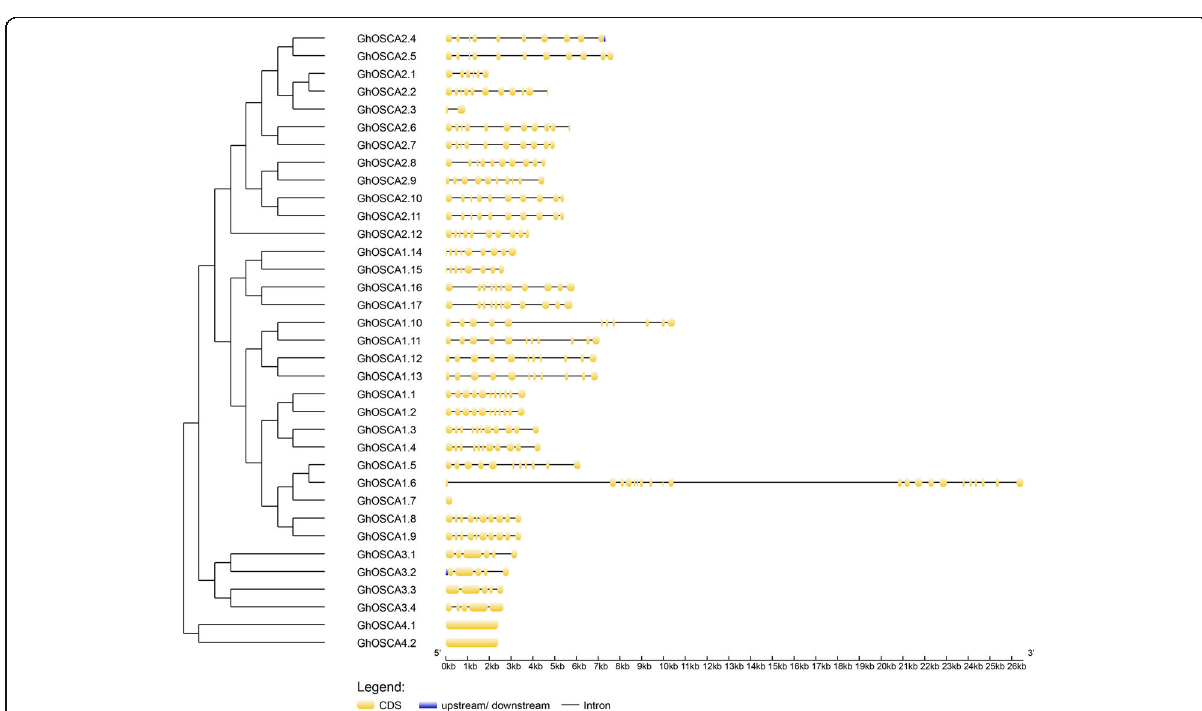
Fig. 3 The gene structure of all members of OSCA gene family in Gossypium